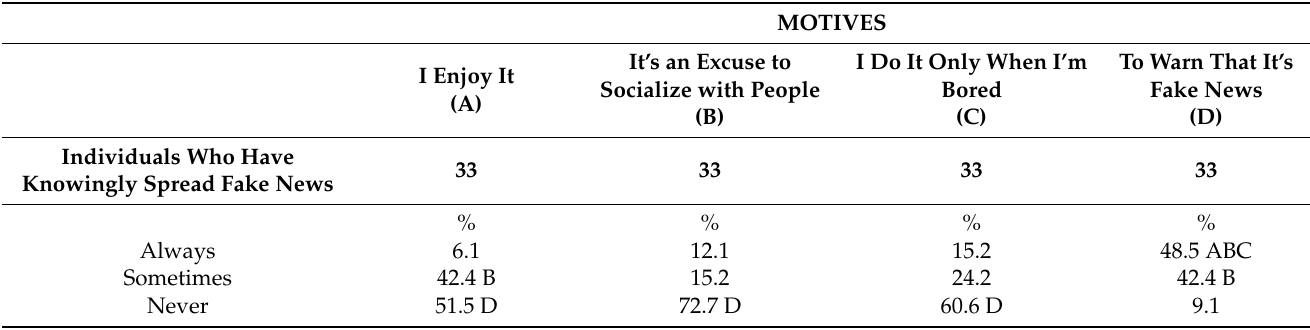
Table 15. Question 11: Complete Q.11 if you answer “Yes” on q. 10) How often do you spread fake news for the following reasons? (Show phrases